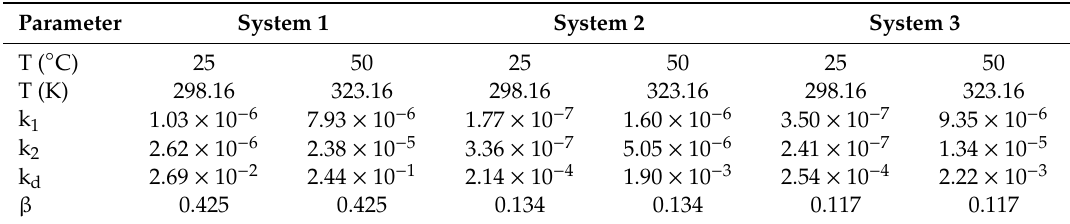
Table 5. Estimated kinetic parameters for the model fitted to all data from acetone (system 1), MEK or butanone (system 2) and cyclohexanone (system 3) ketalization reactions with glycerol at the higher and lower temperature values within the range under